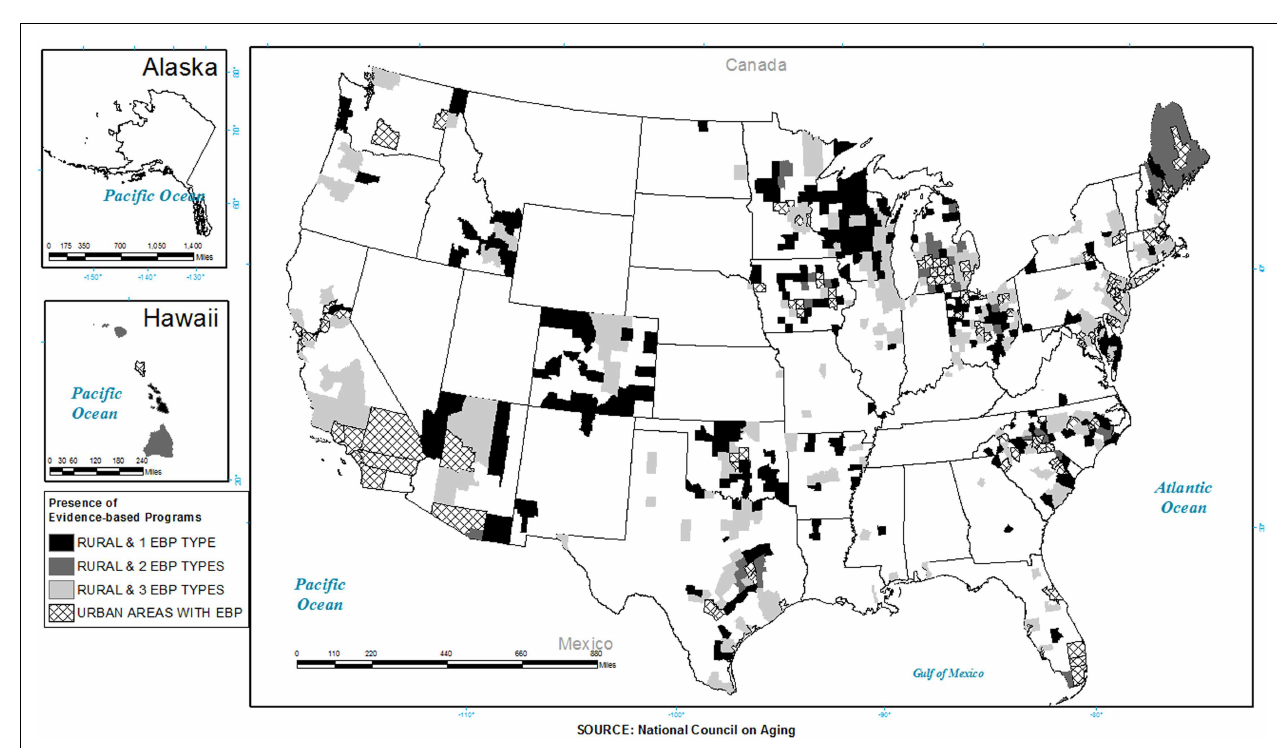
FIGURE 4 | Distribution of evidence-based programs (EnhanceFitness,A Matter of Balance/Volunteer Lay Leader Model and the Chronic Disease Self-Management Program) by county and rurality